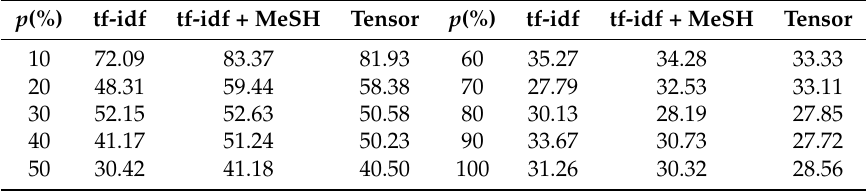
Table 6. Cosine similarity, k-means clustering and